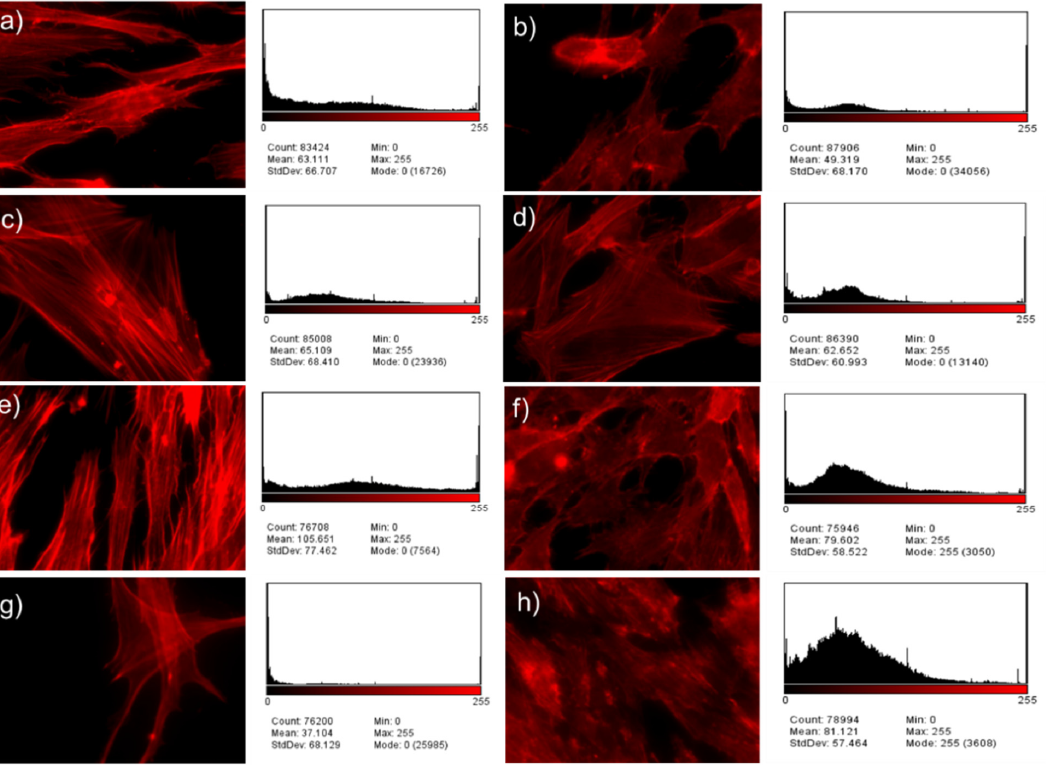
Figure 17. Fluorescence microscopic images stained for the cytoskeleton and their analysis with histograms employing the ImageJ software at 20 × , ( a – d ) are the hDPSCs and MG-63 cells cultivated on flat surfaces in conventional and differentiation media in relation to Figure 15; ( e – h ) are the hDPSCs and MG-63 cells cultivated on as-cast TNZT surfaces in conventional and differentiation media in relation to Figure 16.